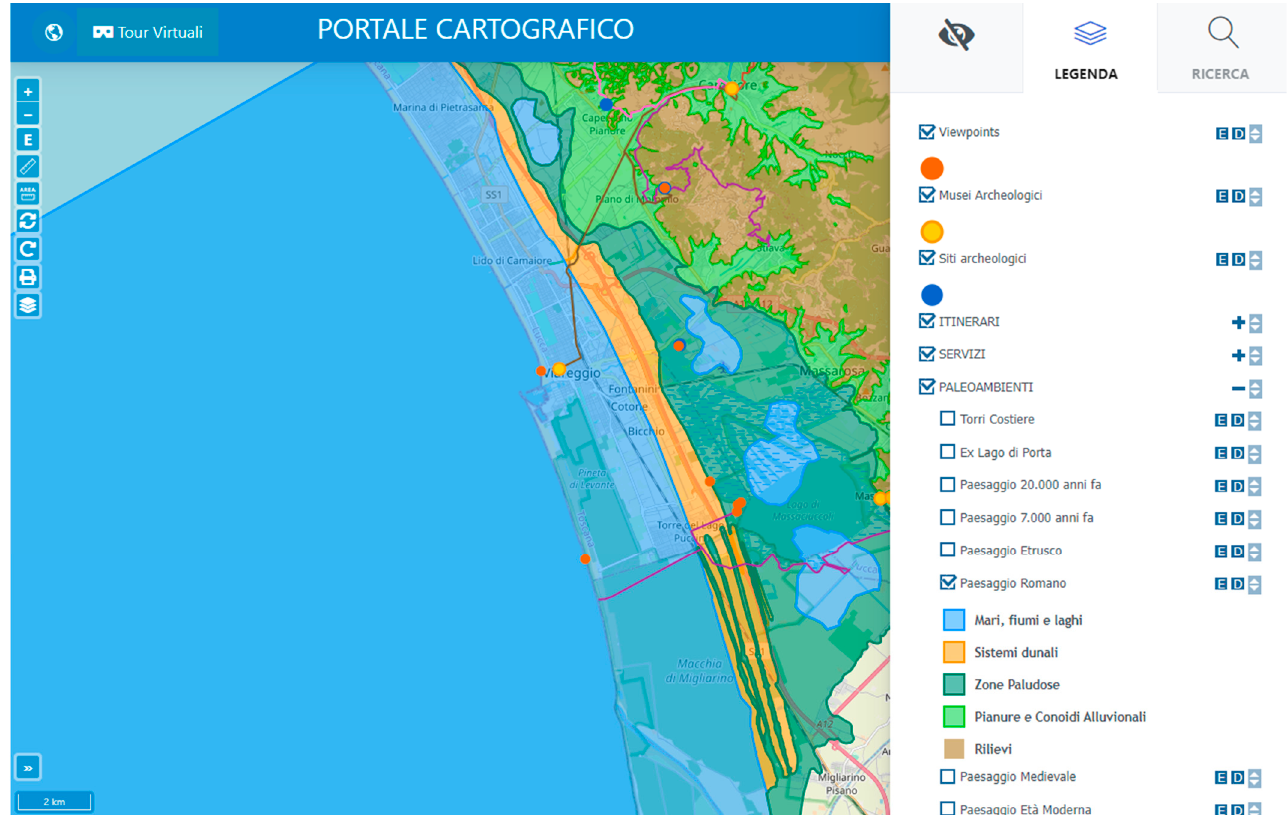
Figure 6. Web application developed in this study. The application is a web GIS reporting all the results of this study (palaeoenvironmental maps, heritage and virtual tours). The web application aims to improve the link between results and to provide an interface for querying and disclosure of the